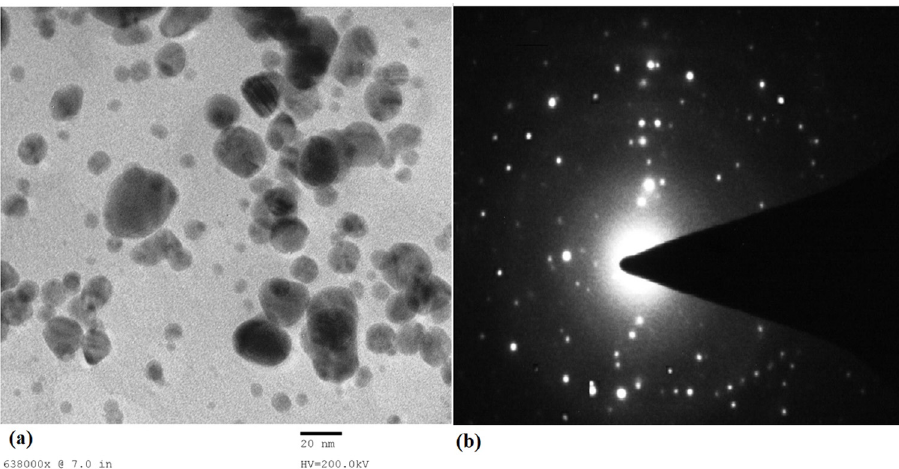
Figure 6: ( a ) TEM images showing the circular shape of the synthesized AgNPs and ( b ) the selected area of electron di ff raction ( SAED ) pattern of silver nanoparticles chosen at random.